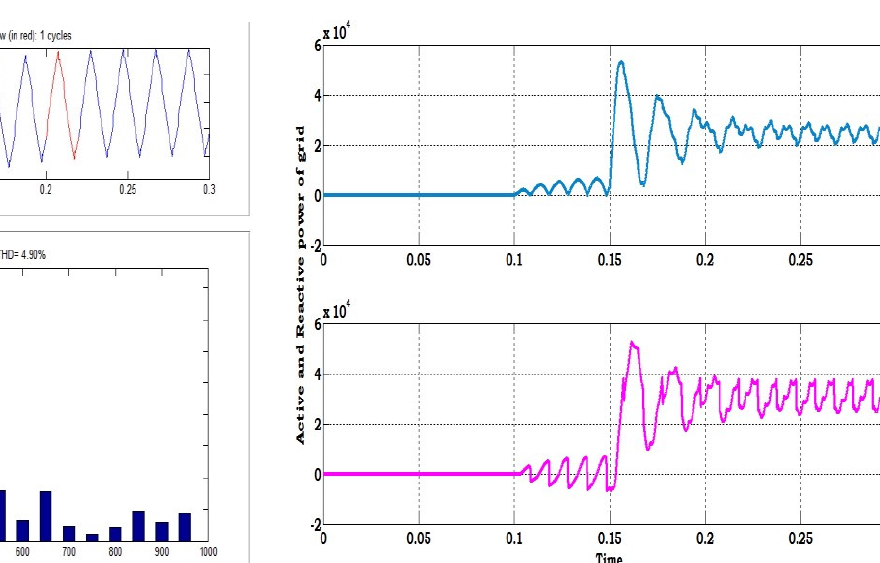
Figure 13. THD Waveforms of Voltage at PCC